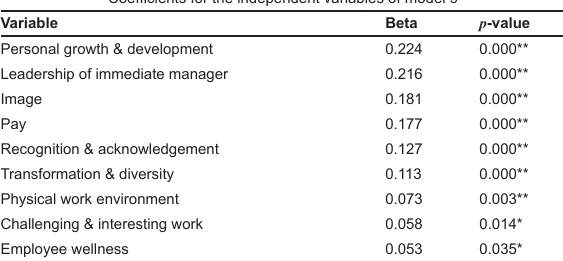
Table 8 Coefficients for the independent variables of model 9